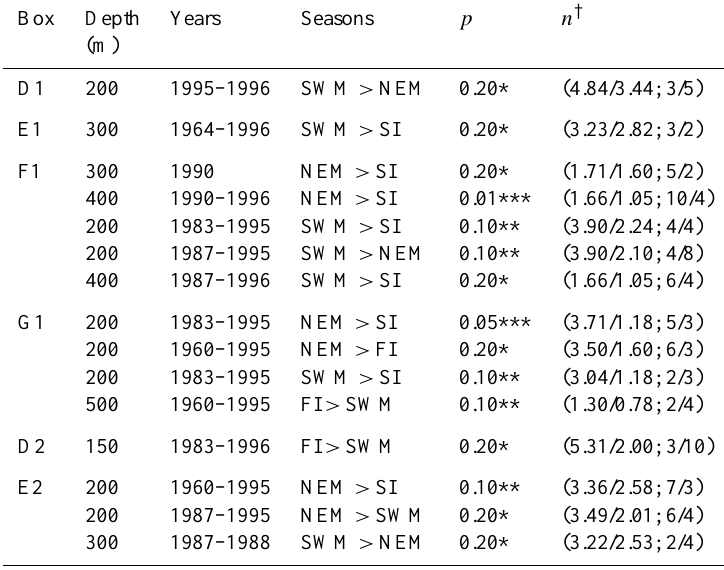
Table 7. Significant seasonal differences in median NO − concentrations with n ≥ 2 ( > 0.5µM) in the OMZ for boxes and depths during 2 similar periods. One-sided p : with ≥ 2 values, * ≤ 0.20; ** ≤ 0.10; *** ≤ 0.05. See Fig. 3 for names of seasons and